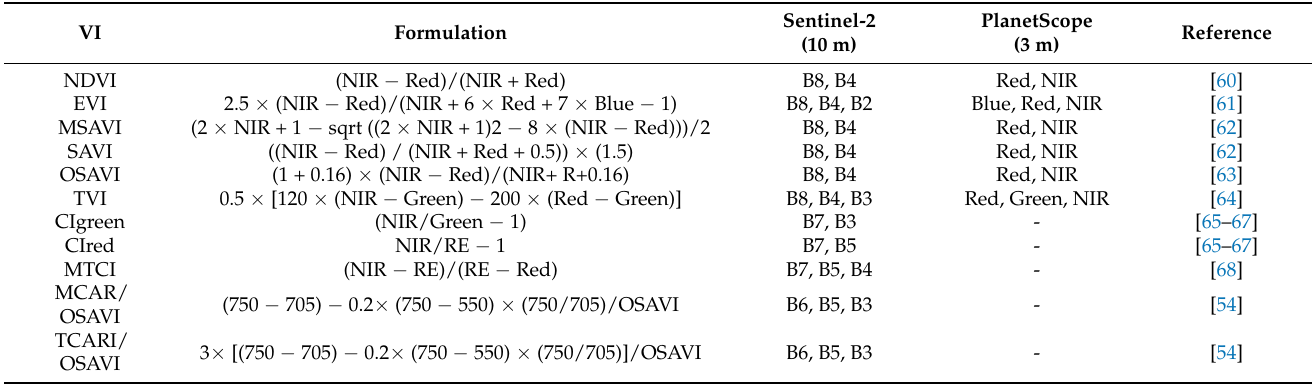
Table 2. Vegetation indices (VIs) and bands from Sentinel-2 and PlanetScope used for crop yield